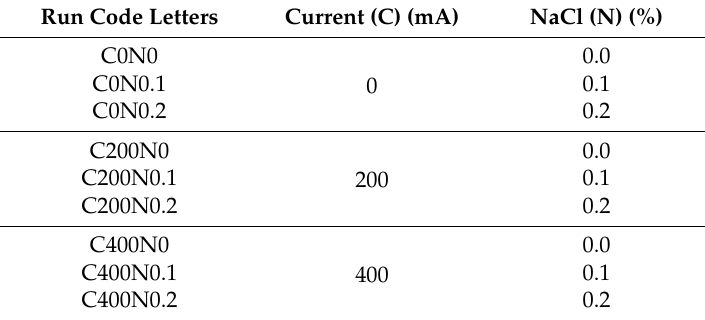
Table 2. The experimental design used for cytotoxicity